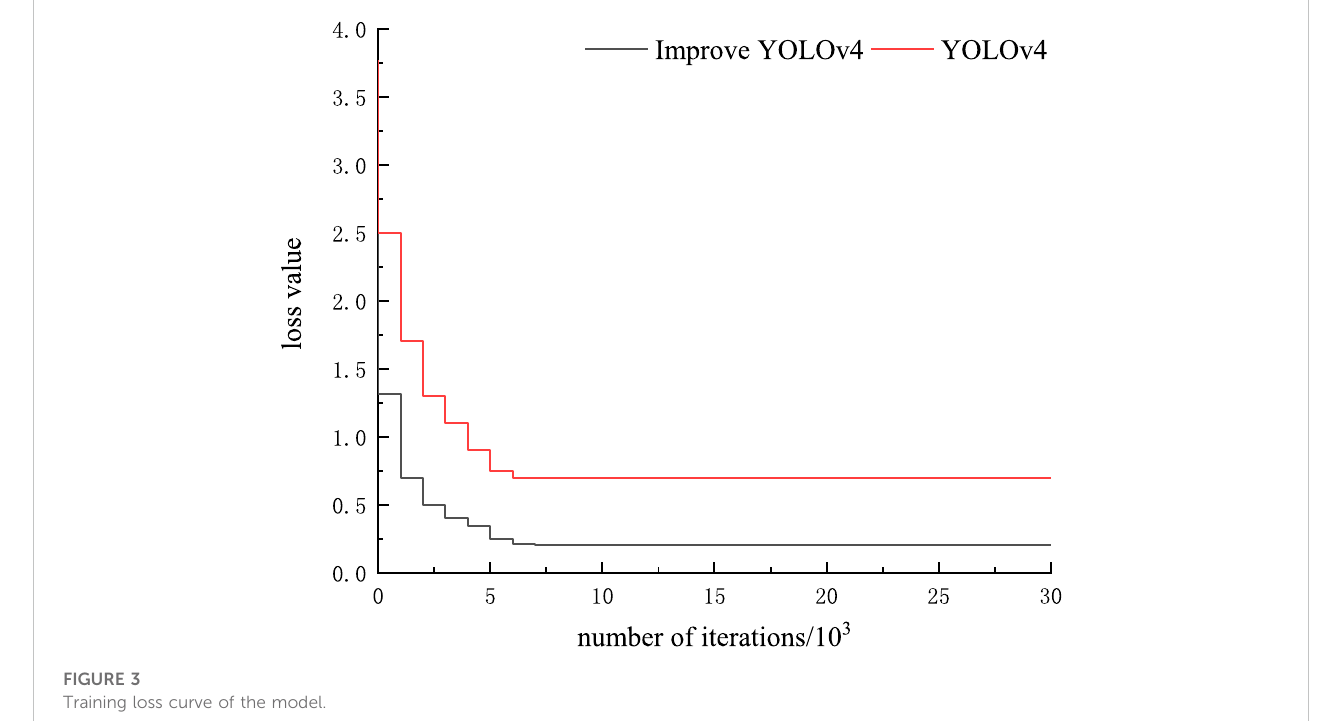
FIGURE 3 Training loss curve of the model.